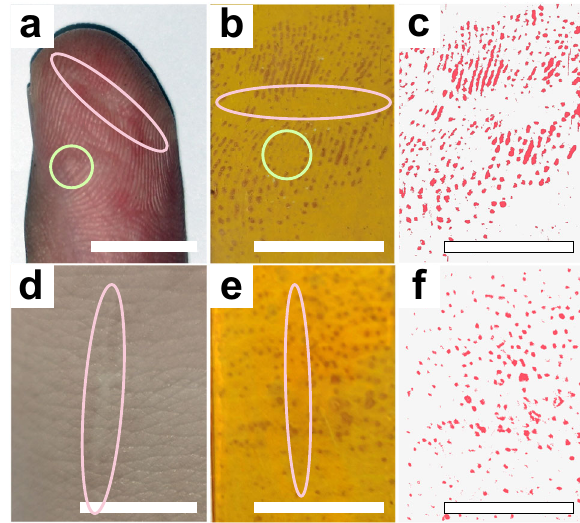
Fig. 6 | Sweat pore images of scars and keratosis. a Photograph of a fi nger with scars (red circle) and mild keratosis (green circle). b Sweat pore images collected from the fi nger in ( a ). c Extracted sweat pore images from ( b ). d Photograph of an area of the inside of an arm with scars (red circle) e Sweat pore images collected from the area in ( d ). f Extracted sweat pore images from ( e ). (Scale bars are 1cm) The red ( c , f )colored images are added pseudocolorsby a Photoshop program for clear